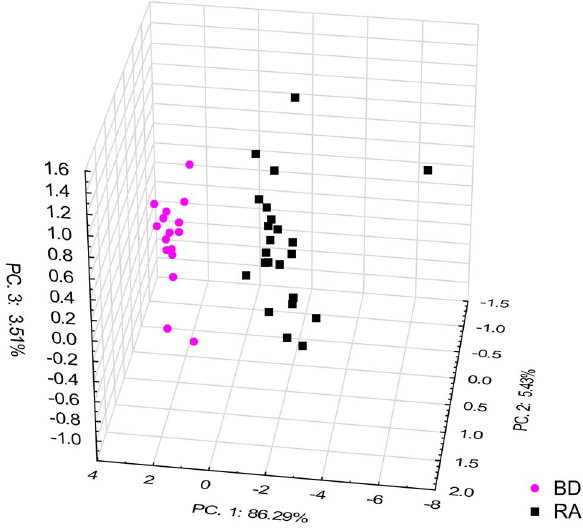
Figure 4. The PCA 3D scatter plot displaying the separation of rheumatoid arthritis patients and healthy blood donors based on wave numbers of 1120, 1105, 852, 2982, 1079, and 1682 cm −1 .